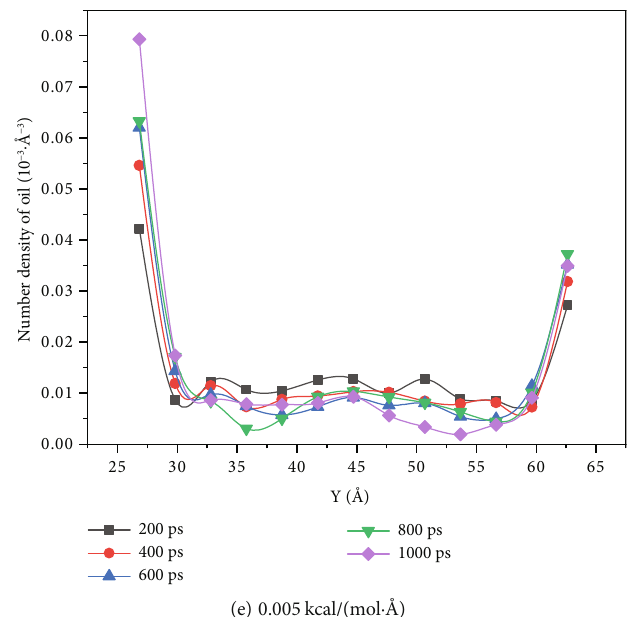
Figure 10: Oil molecular number density distribution at di ff erent times under di ff erent driving